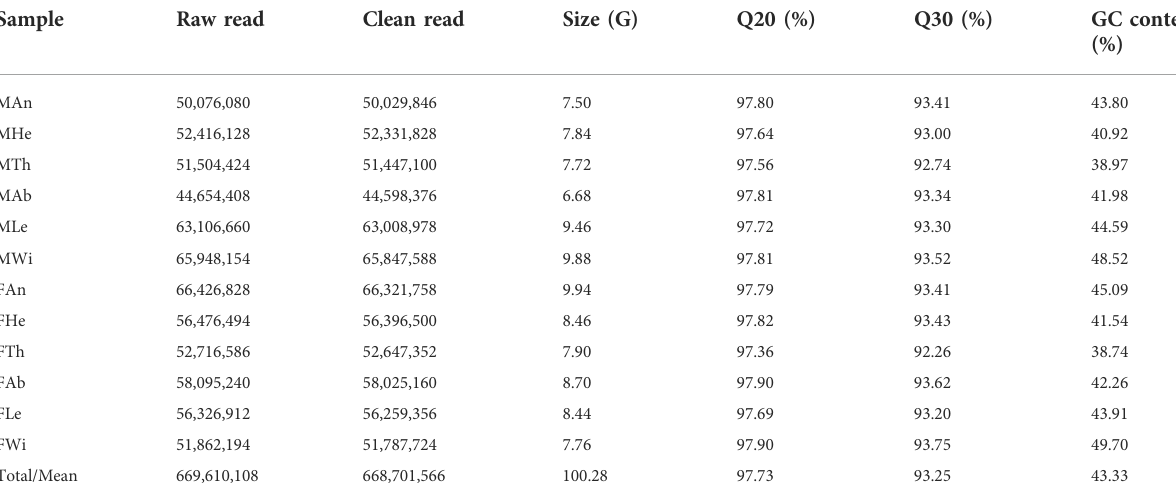
TABLE 1 Summary statistics of the transcriptome in various tissues of P. antennata .